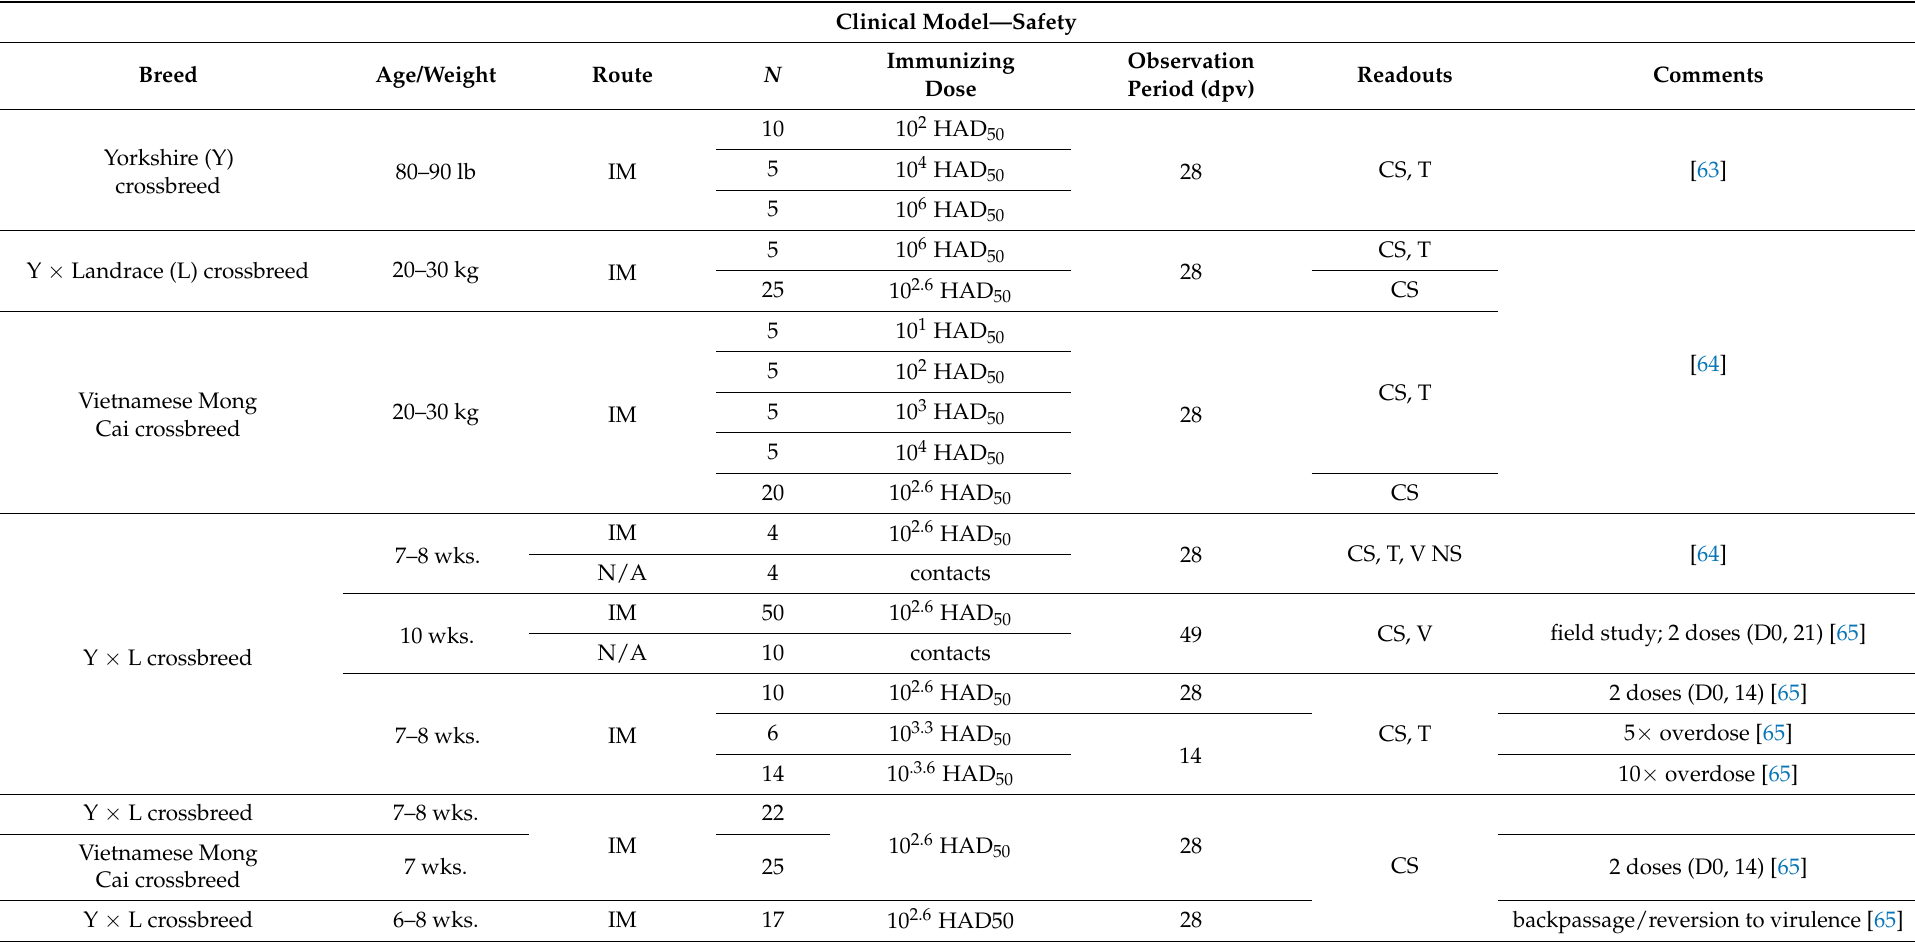
Table 4. ASFV-G- ∆ I177L Licensed Vaccine—Safety